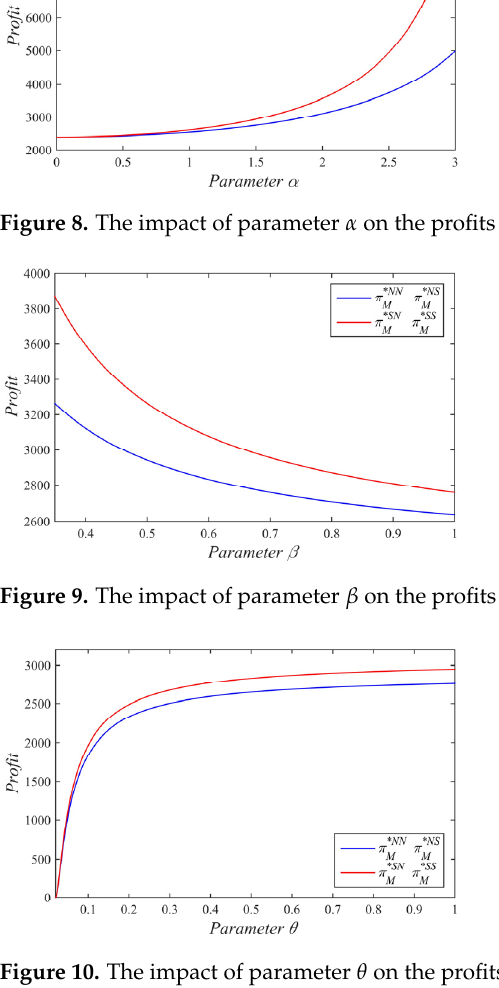
Figure 10. The impact of parameter